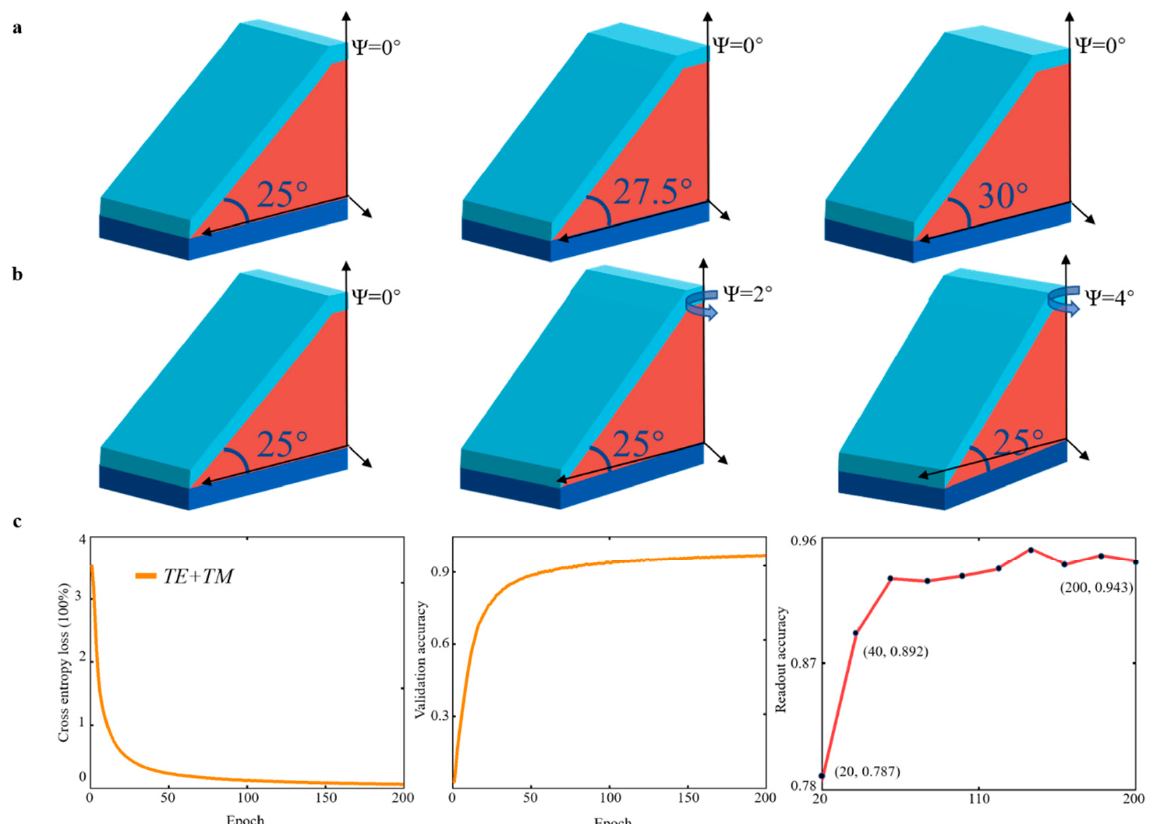
Figure 9. Description of the encoding method and readout accuracy: ( a ) The azimuth angle ψ is fixed (0 ◦ ), and the slope angle α increases gradually in 2.5 ◦ intervals from 25 ◦ to 62.5 ◦ . ( b ) The slope angle α is fixed (25 ◦ ), and the azimuth angle ψ increases gradually from 0 ◦ to 10 ◦ at 2 ◦ intervals ( c ) TE + TM polarization for cross-entropy loss and training for validation accuracy; 96 data sets of reduced wavelength spectra for network testing for readout accuracy.